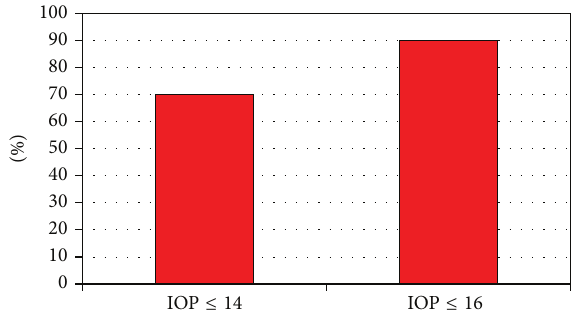
Figure 3: Percentage of patients with complete success (without medication) for a given target IOP in mmHg after 2 years of follow-